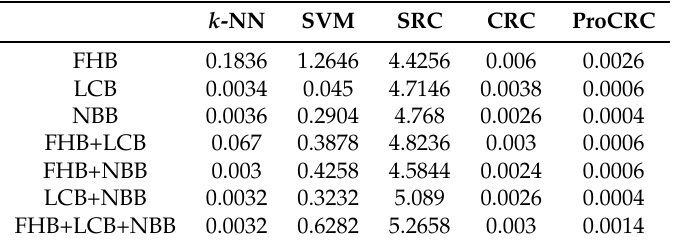
Table 4. Running time (seconds) of the five